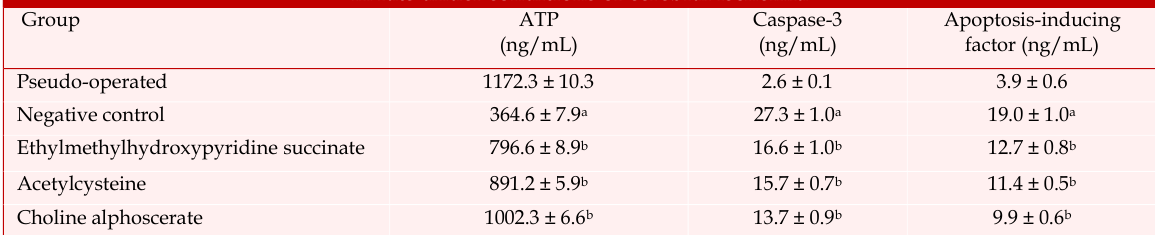
Note: a statistically significant relative to the pseudo-operated group of animals (p<0.05, Newman-Keuls criterion); b statistically significant rela- tive to the negative control group of animals (p<0.05, Newman-Keuls